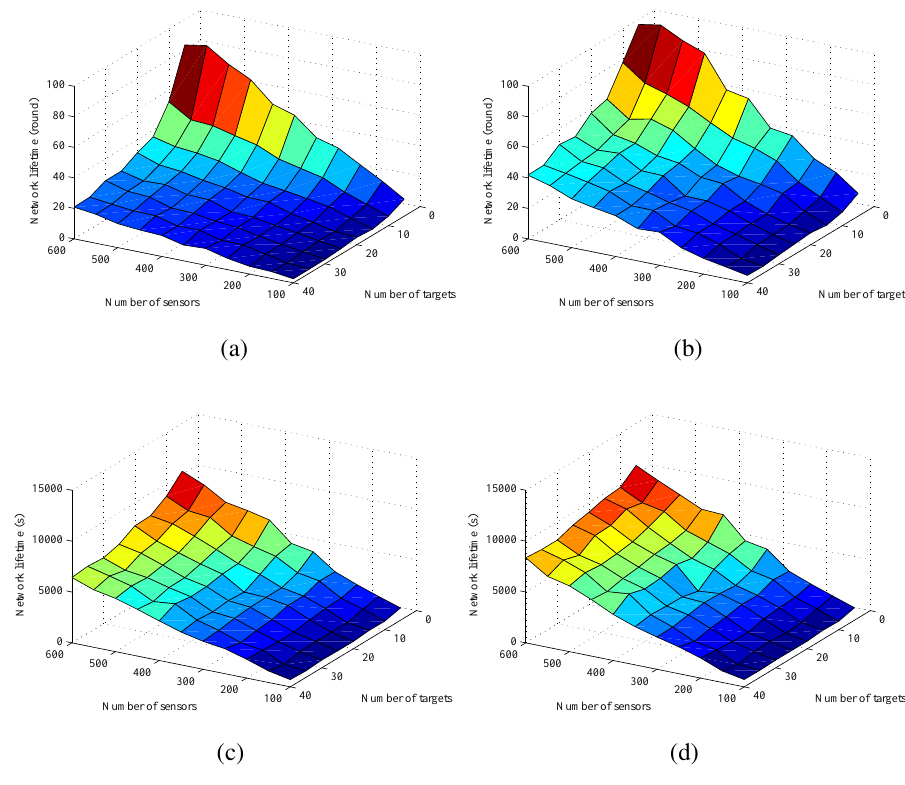
Figure 8. Comprehensive comparisons of REFS and EEFS. The impact of the numbers of sensors and targets on the network lifetime in terms of (a) REFS and (b) EEFS in scenario 1 as well as (c) REFS and (d) EEFS in scenario